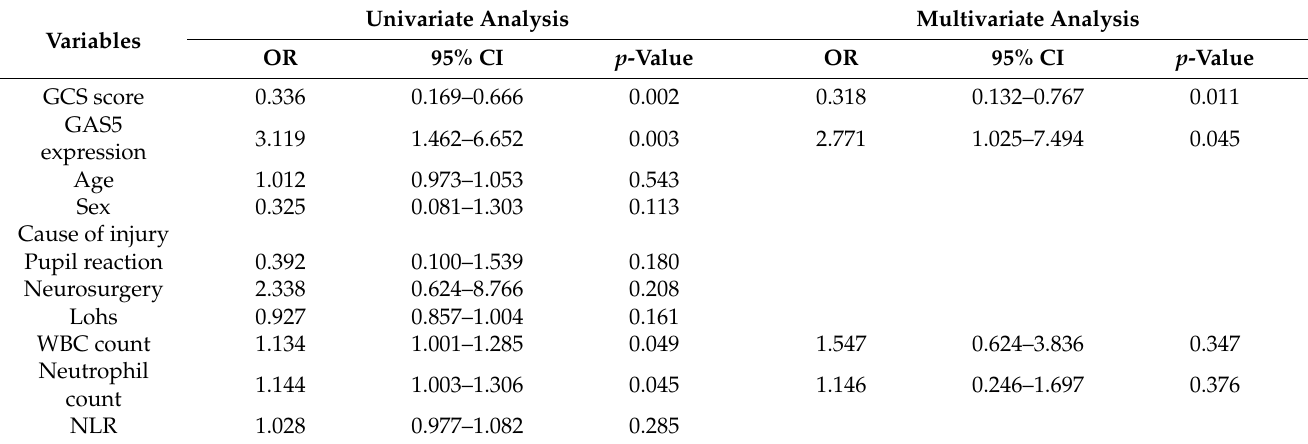
Table 2. Univariate and multivariate logistic analyses for the prognostic factors of severe TBI.